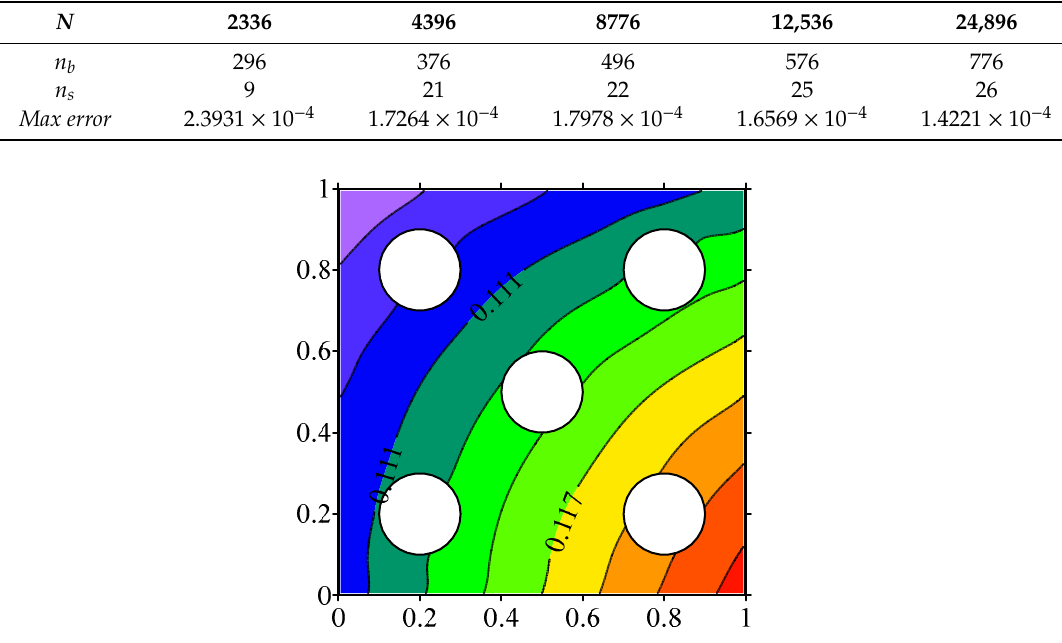
Figure 10. Distribution of the numerical solution for test 2 in case 4.